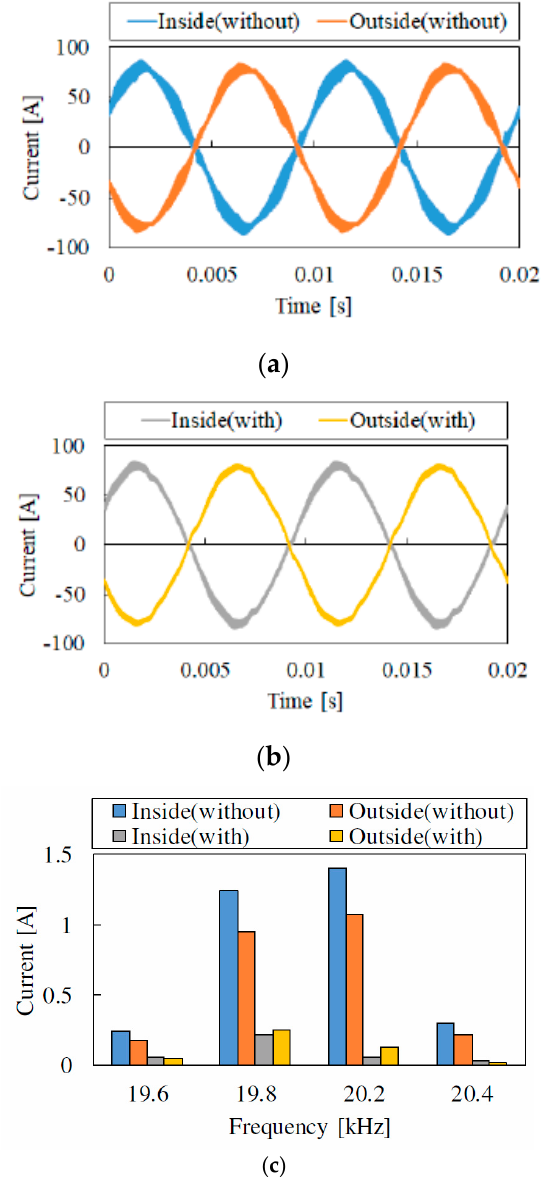
Figure 15. ( a ) Current waveforms without carrier shift control. ( b ) Current waveforms with carrier shift control. ( c ) FFT results of current waveforms.